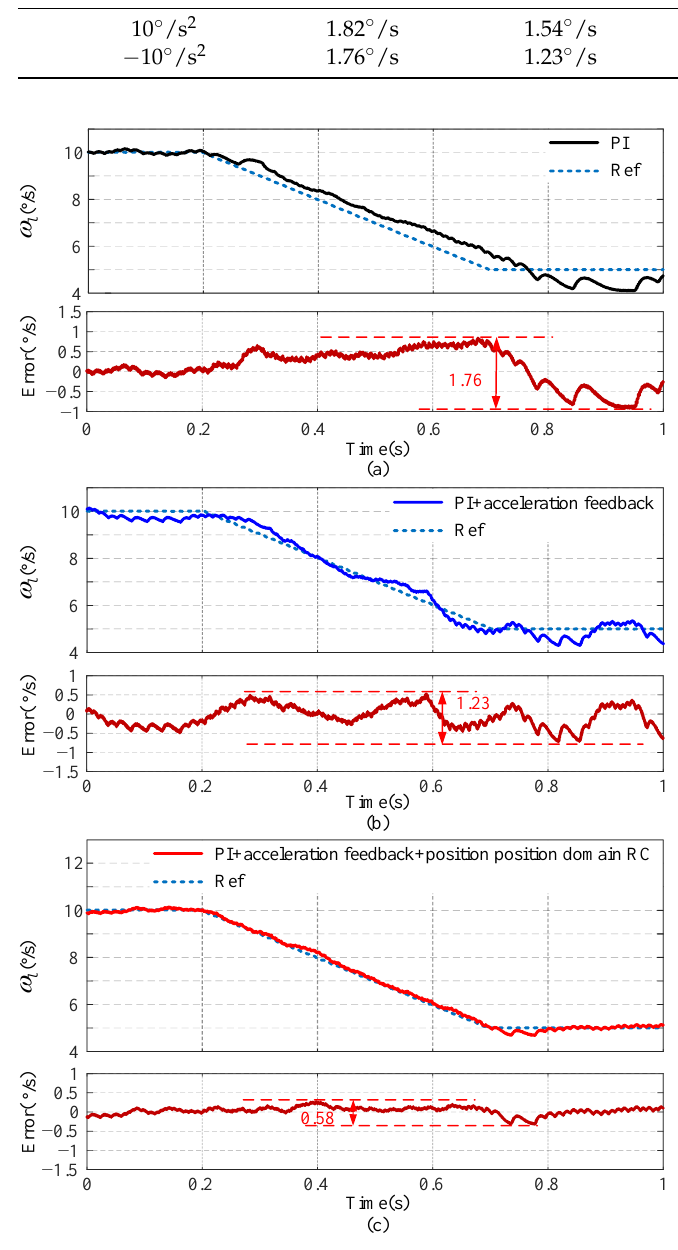
Figure 15. Experimental results of load angular speed and tracking error at reverse variable speed motion: ( a ) PI; ( b ) PI+acceleration feedback; ( c ) PI+acceleration feedback+position domain